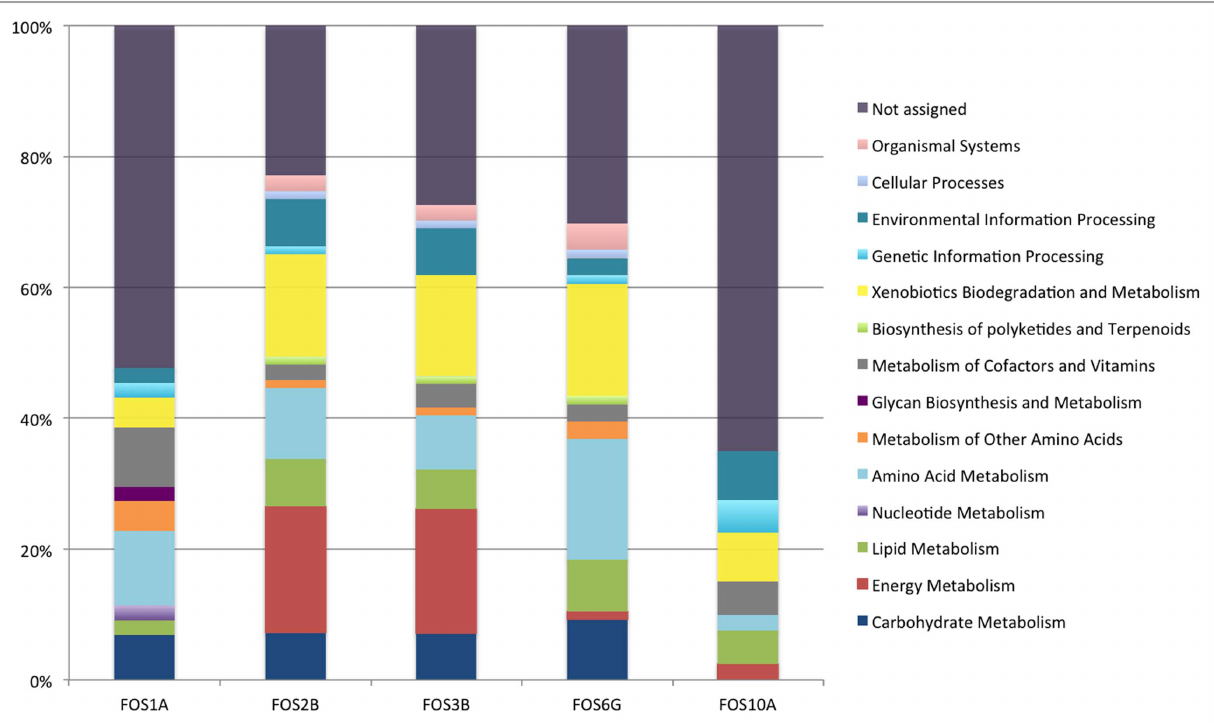
Figure 4. KEGG-based functional assignment of the sequences from the metagenomic fosmid clones.